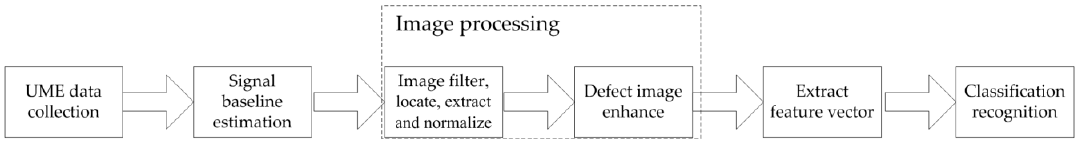
Figure 2. Discontinuity recognition flow chart.